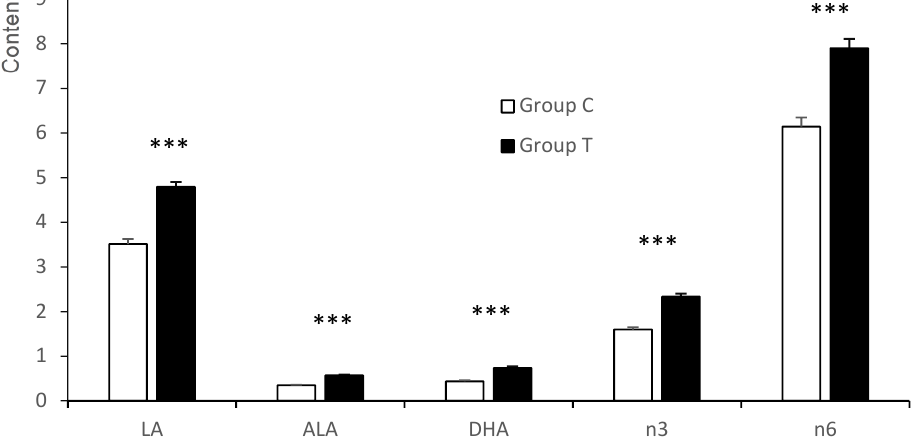
Figure 2. Significant differences in the n3 and n6-PUFA series of the neutral fraction of the longissimus dorsi muscle between fetuses obtained at 100 days of gestation born from control gilts (group C) or from gilts treated with hydroxytyrosol and linseed oil from day 35 to day 100 of gestation (group T). LA = linoleic acid; ALA = α -linolenic acid; DHA = docosahexaenoic acid; n3 = total sum of n3-Polyunsaturated fatty acid; n6 = total sum of n6-Polyunsaturated fatty acid. *** p < 0.001.